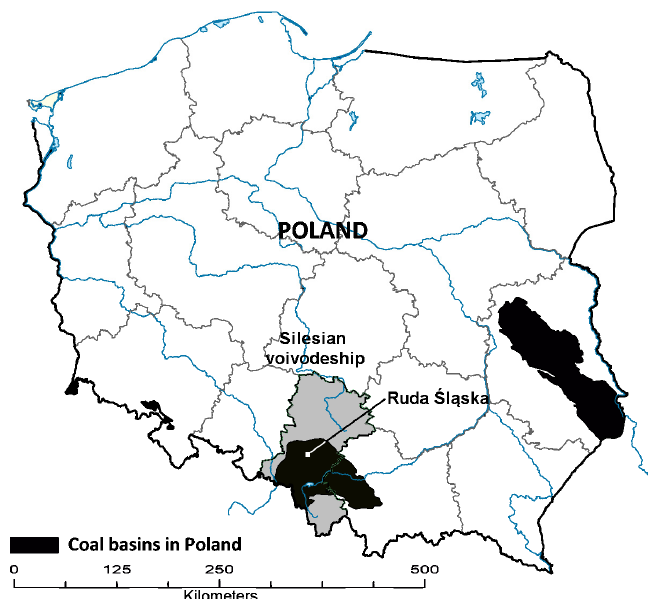
Figure 1. Area of analysis (Silesian Voivodeship, south of Poland).